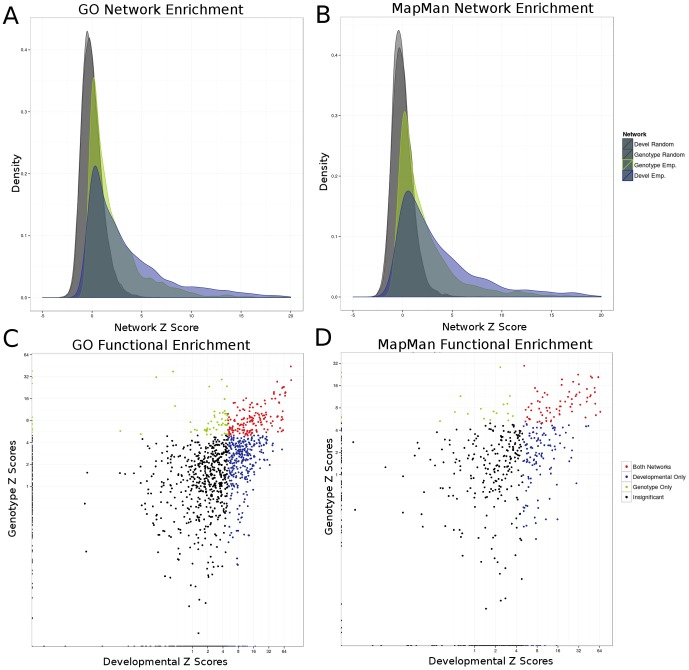
Enrichment for GO and MapMan terms in co-expression networks.Enrichment of highly co-expressed interactions among sets of genes in the network was calculated using both the Gene Ontology (GO) standard as well as the MapMan (MM) standard using the Z-test. Interactions among random sets of genes with the same size as GO and MM were calculated and compared to empirical interactions showing that interaction densities in empirical data are stronger in both networks for both GO (A) and MM (B). Individual annotation terms are plotted against each other in each network (C–D) showing that certain terms are more represented in a single network (green and blue points) or represented by both networks (red points).